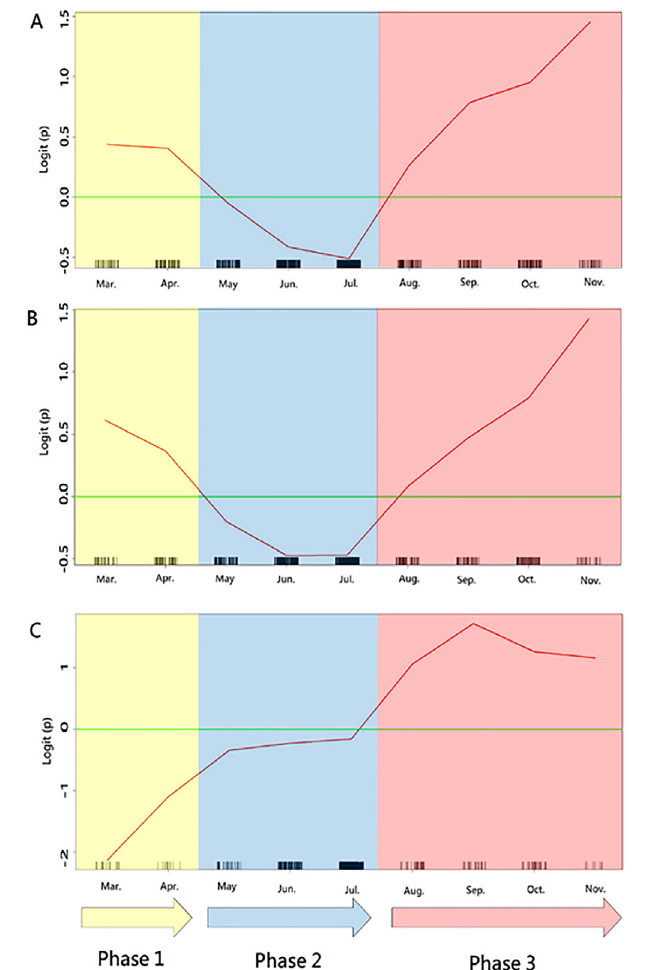
Figure 2. Generalized additive model plots for nonparametric modelling of the mortality variation (represented as logit of the probability of death) during different pandemic phases. A. Total cohort; B. Urban hospitals; C. Suburban hospitals. Logit (p), where p represented the probability for death.